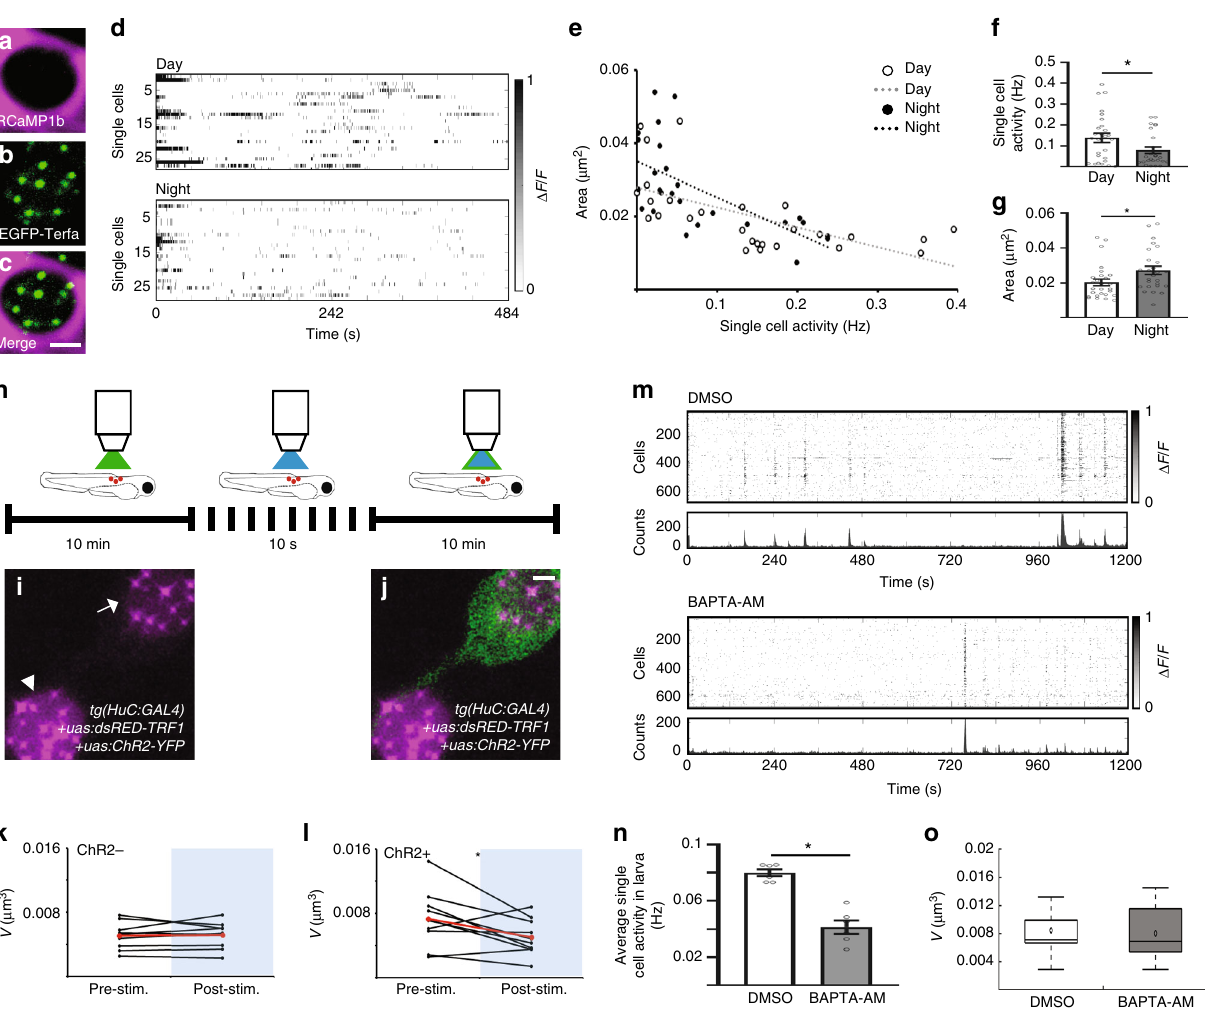
Fig. 4 Neuronal excitation reduces chromosome dynamics in the Rh and SC. a – c Simultaneous 2D imaging of neuronal activity (magenta) and chromosome dynamics (green) in the Rh neurons. d Raster plot of Δ F / F of 27 and 26 RCaMP1b-expressing single cells during day and night, respectively. Grayscale: Δ F / F amplitude. e A moderate negative correlation between chromosome dynamics and neuronal activity during day and night ( R = − 0.62, R = Day Night − 0.64, R = − 0.64), determined by Pearson correlation coef fi cient. The average single-cell activity ( f , * P = 0.035) and chromosome dynamics Total activity ( g , * P dynamics = 0.03) during day and night. Determined by two-tailed t -test: two samples assuming unequal variance. h – l Optogenetic stimulation of neuronal activity reduces chromosome dynamics. h – j The neurons expressed both dsRED-TRF1 and ChR2-YFP (arrow) or only dsRED-TRF1 (arrowhead). k , l Chromosome dynamics before and following the light stimuli (ChR2 − , n = 9 cells; ChR2 + , n = 10 cells). * P = 0.031, determined by two-tailed t -test: two-paired samples for means. Average change is marked by red line. m – o Inhibition of neuronal activity during the night does not affect chromosome dynamics. m Representative raster plots of Δ F / F in the Rh of 6 dpf tg(HuC:GCaMP5) larvae under DMSO ( n = 6 larvae) or BAPTA-AM ( n = 6 larvae) treatments. Grayscale: Δ F / F amplitude. Bottom: histogram of the Ca 2 + transients of all cells. n Average spontaneous neuronal activity in single neurons of the Rh under either DMSO ( n = 6 larvae) or BAPTA-AM ( n = 6 larvae) treatment (ZT23). * P = 2 × 10 − 4 , t = 2.3, degrees of freedom = 7, determined by two-tailed t -test: two samples assuming unequal variance. o Volume of chromosome dynamics during nighttime (ZT23) in DMSO ( n = 13 cells) and BAPTA-AM ( n = 11 cells)-treated larvae. Values are presented as boxplots and means (black diamonds) or as dot plots and means ± SEM. Boxplots indicate the median and the 25th-to-75th percentiles. The whiskers extend to the most extreme data points. ZT zeitgeber time. Scale bar = 2 µ m